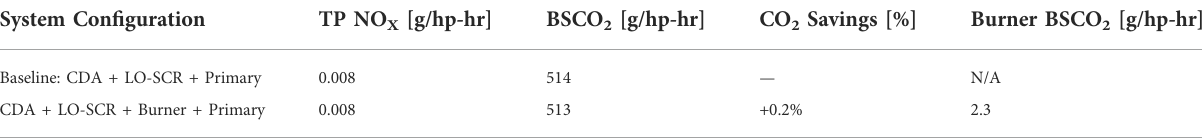
TABLE 6 Hot start HD-FTP results comparison between Baseline and CDA + LO-SCR + Burner + Primary system. System Con fi guration